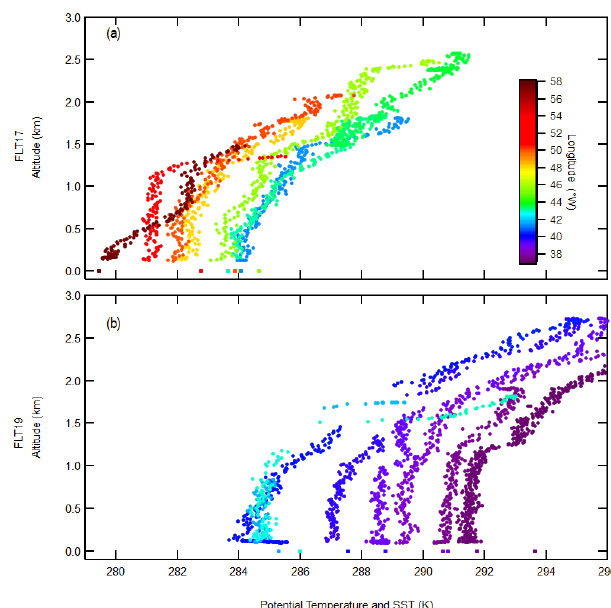
Figure 5. Vertical profiles of the potential temperature from C130 flights that occurred on (a) 17 September 2019 and (b) 19 Septem- ber 2019 (Figs. 3a and 4a). In-cloud measurements are excluded. Vertical profiles with horizontal in-cloud legs are excluded as well as a few others that have significant overlap with the presented verti- cal profiles. Surface measurements (at 0km) represent the SST just below the lowest point in the vertical profile. The point color repre- sents the longitude at which the measurement was made. Air mass transitions from open-cell to closed-cell clouds and from closed- cell to cloud-free air on the 17 September 2019 flight occurred at approximately 52 and 56 ◦ W, respectively. None of the vertical pro- files are in the closed-cell region for the 19 September 2019